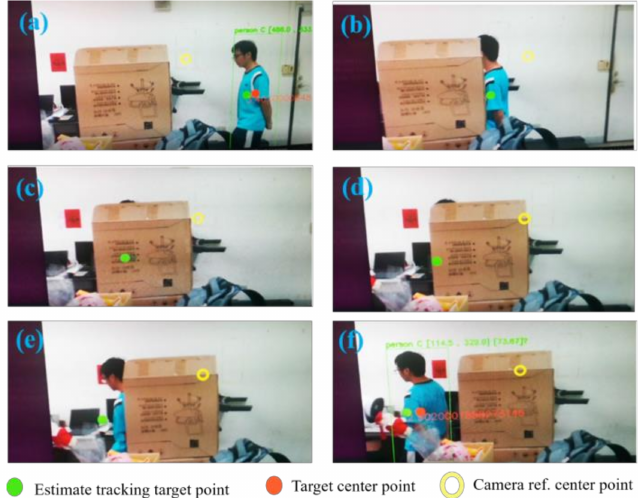
Figure 19. The experimental results of the target trajectory estimation.